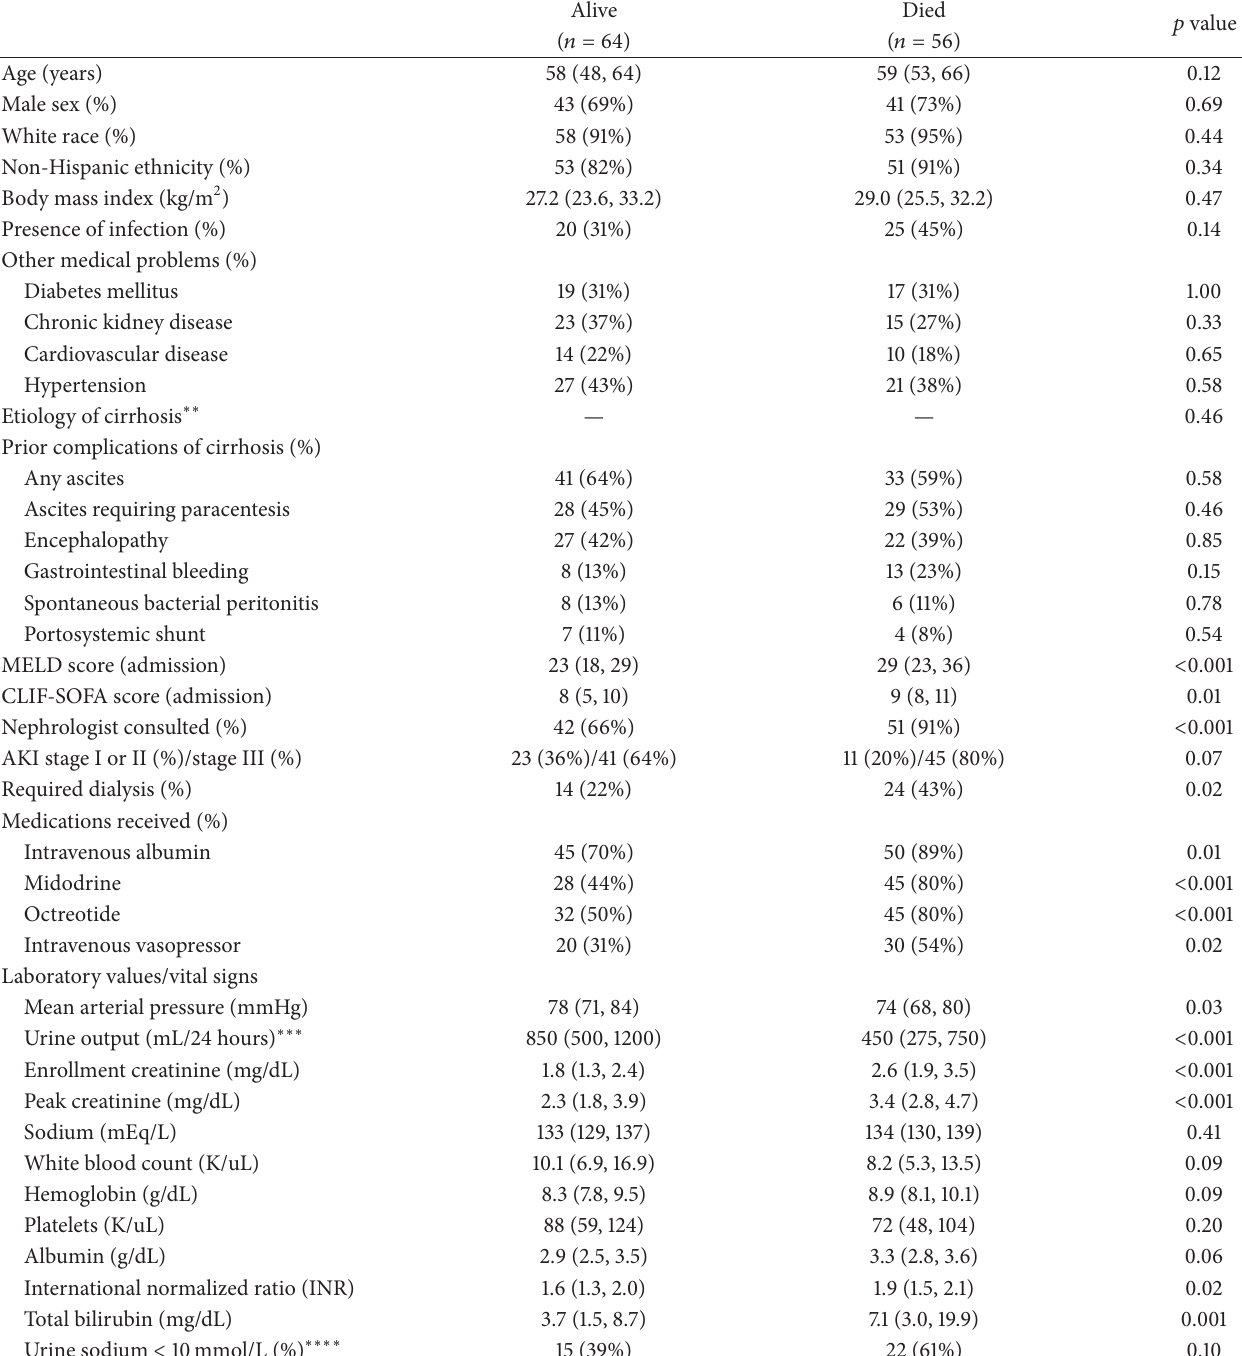
Table 2: Relationship of variables to death at 90 days for all participants ∗